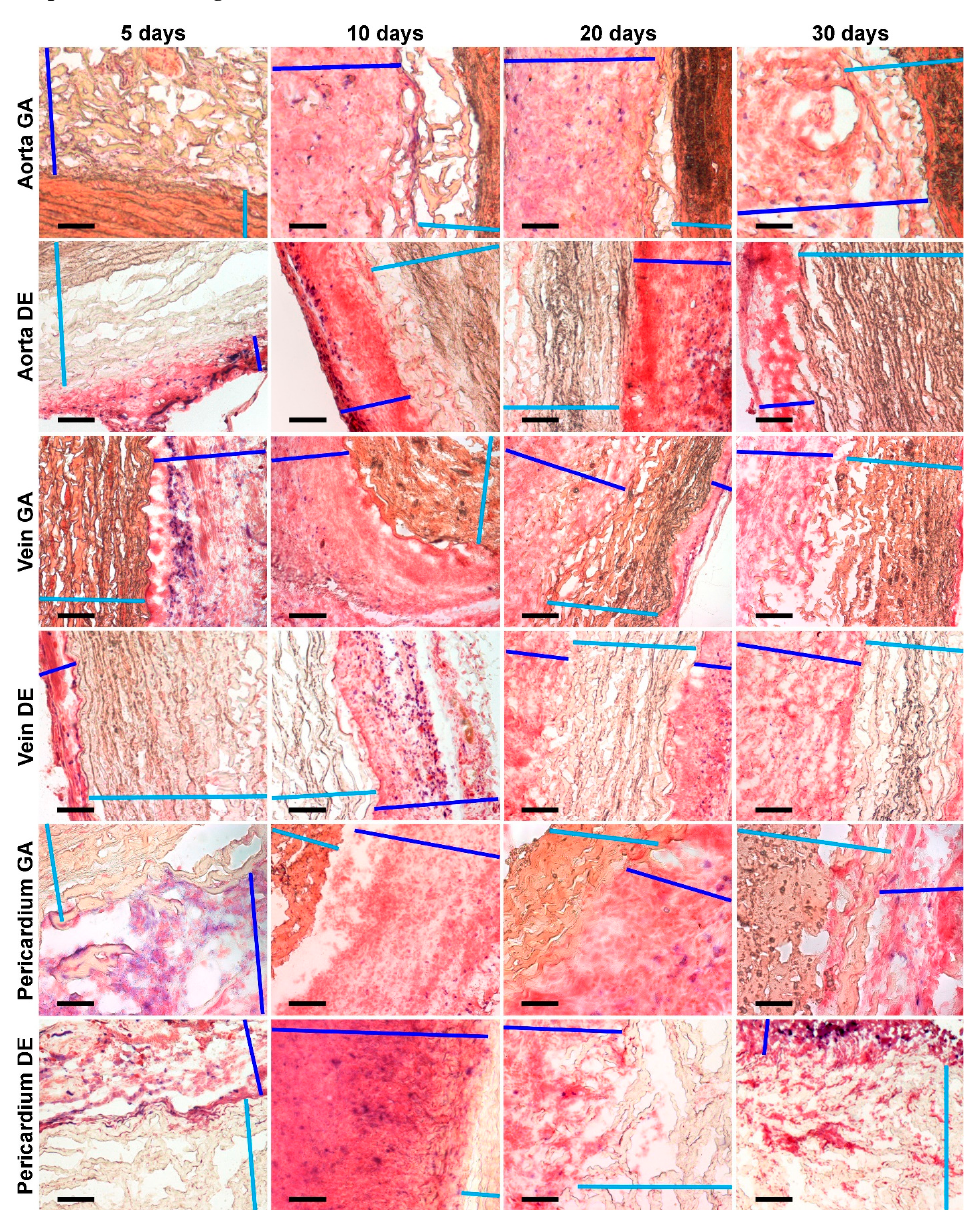
Figure 7. Histochemical visualization of ALP (deep blue spots) localized in connective tissue capsules but not in implants’ tissues. Light blue color marks implant tissues; deep blue lines show connective tissue capsules. Scale bars 200 µm.